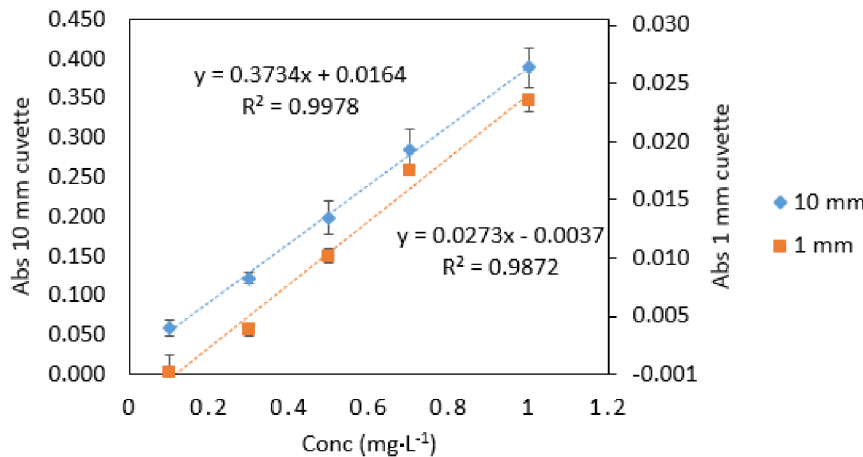
Figure 3. Comparison of Cr VI standards (0.1–1 mg · L − 1 ) measured in quartz cuvettes with 10 mm and 1 mm path lengths. All measurements were carried out in triplicate ( n = 3).